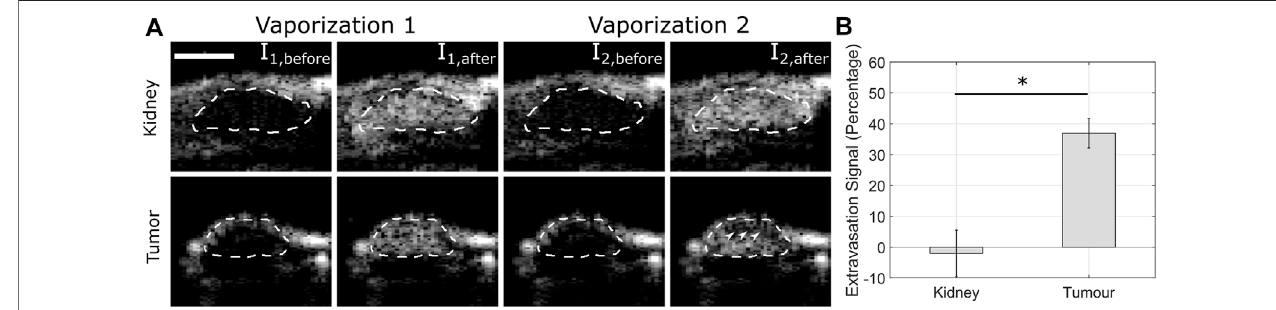
FIGURE3| Estimateddropletextravasationsignalislargerintumorthaninkidney. (A) Twosuccessivevaporizationsequences(Vaporization1and2)separatedby 30 sweretransmittedtoboththekidney(highlyintravascularorgan)andtumorxenograft(intravascularandextravascularcomponents)inamousemodel,outlinedinthe dashedlines.Thewhitearrowheadsdenotethelackofsignalenhancementfromthesecondvaporizationpulsewithinthetumor,suggestingdropletextravasation.Scale baris5 mm. (B) Quanti fi cationofextravasationsignal( p < 0.001).ReprintedbypermissionofElsevierfromHel fi eldetalUltrasoundandMedicineandBiology,2020 [94], see the reference for more